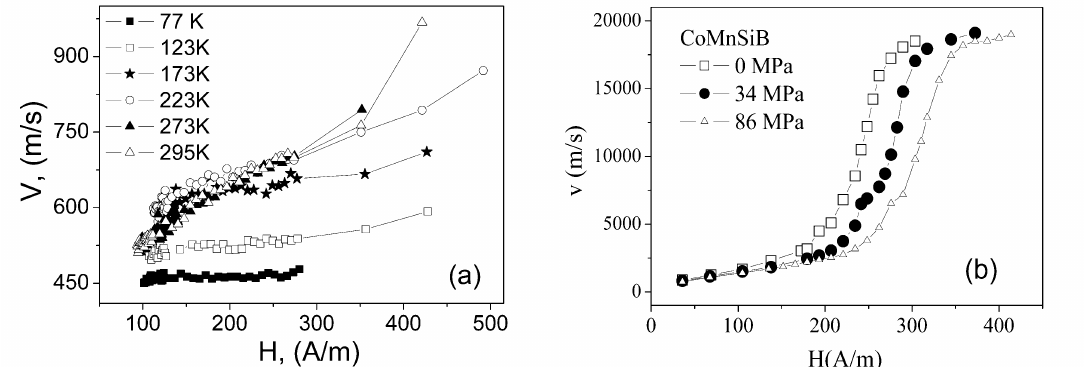
Figure 6. (a): v(H) dependence measured for the Fe of metallic nucleus, d = 14 μm at different temperatures, T and (b): for the Co microwire with d = 8 μm at different applied stress